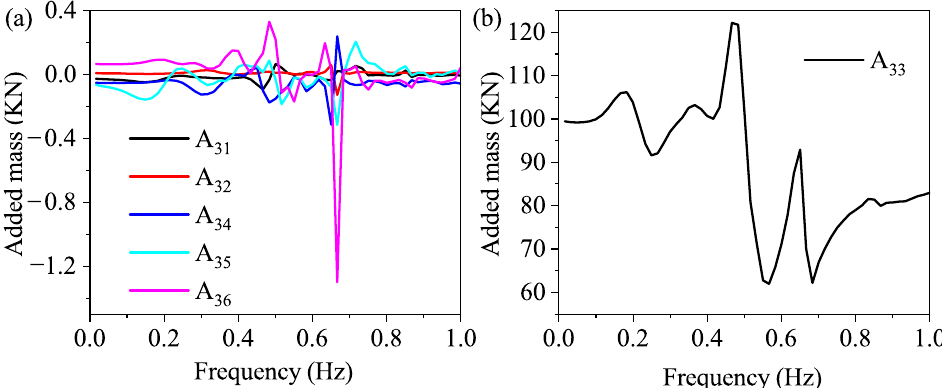
Figure 14. ( a ) The added mass A 31 , A 32 , A 34 , A 35 , A 36 ; ( b ) The added mass A 33 .